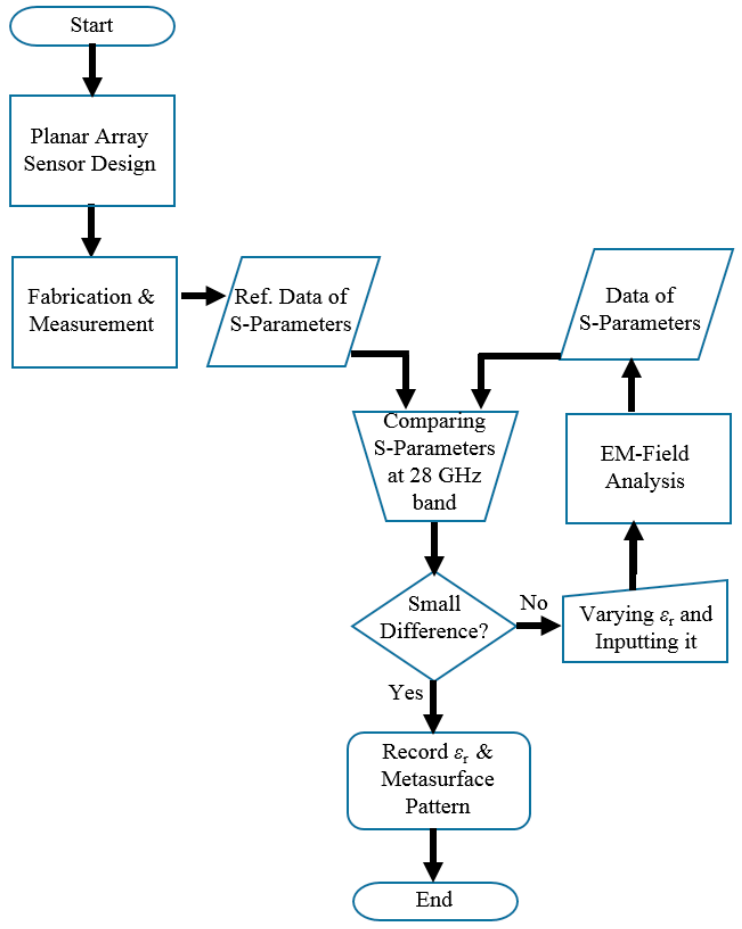
Figure 4. Flow chart of characterizing the permittivity of the material under test linked with the proposed impedance-matched sensor.